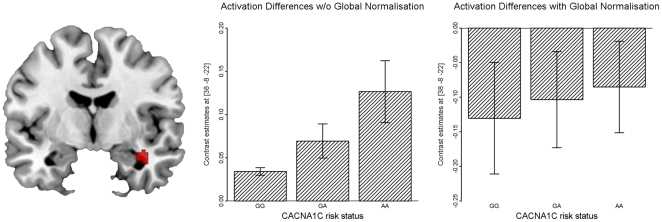
Influence of Noise Regression Methods on the Comparisons of Genetic Groups.A linear increase with with rs1006737 genotype in functional coupling between the right DLPFC (seed voxel) and the right hippocampus is detected for both noise reduction algorithms. However, the interpretation of the changes depending on the underlying correlation profile. While in the “standard implementation” one would argue that the hippocampus is decoupled in GG carriers and that coupling increases with genetic risk (GG<GA<AA), after global normalization the results suggest that medial temporal areas are anticorrelated with the DLPFC and at increasing genetic risk this negative coupling is downregulated.